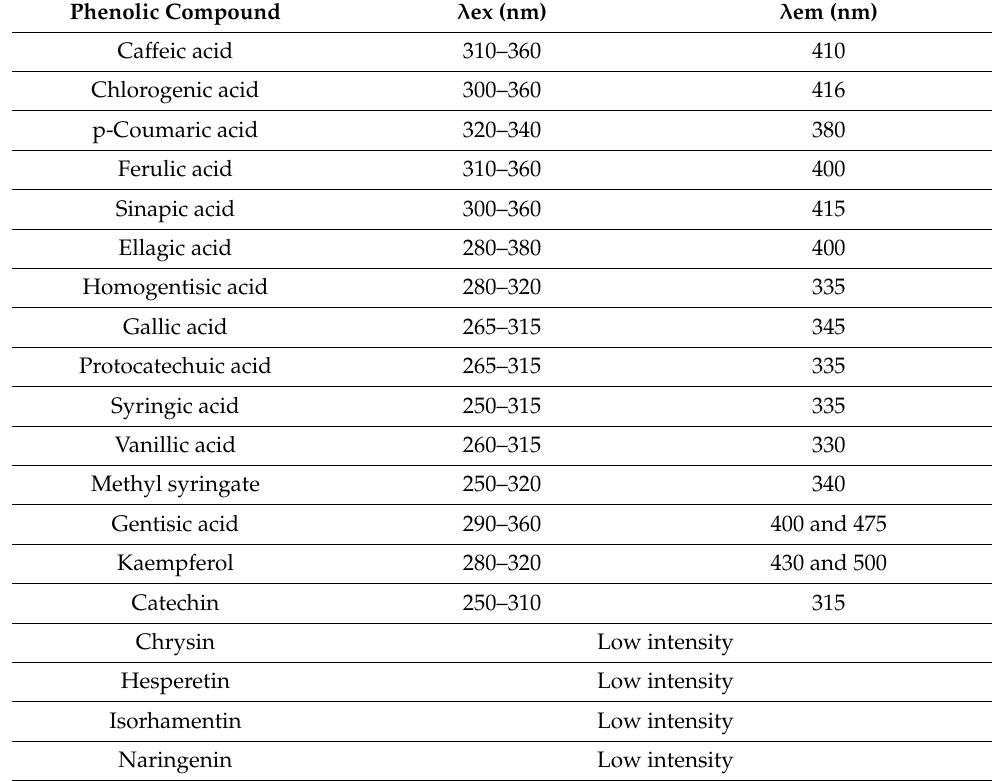
Table 2. The wavelengths of λ ex and λ em of standards phenolic